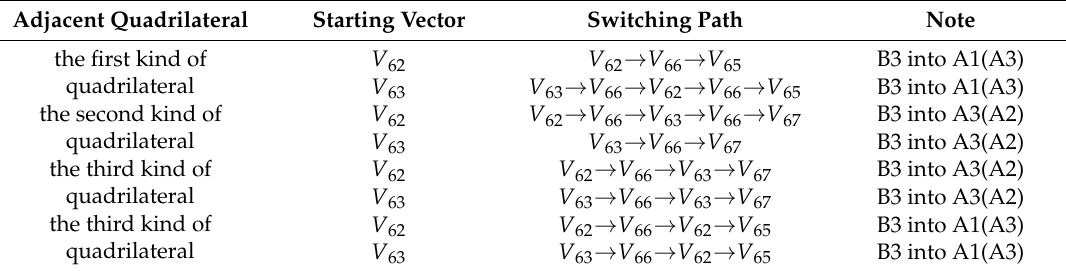
Table 4. Feasible switching paths between the third kind and other kinds of quadrilateral. Adjacent Quadrilateral